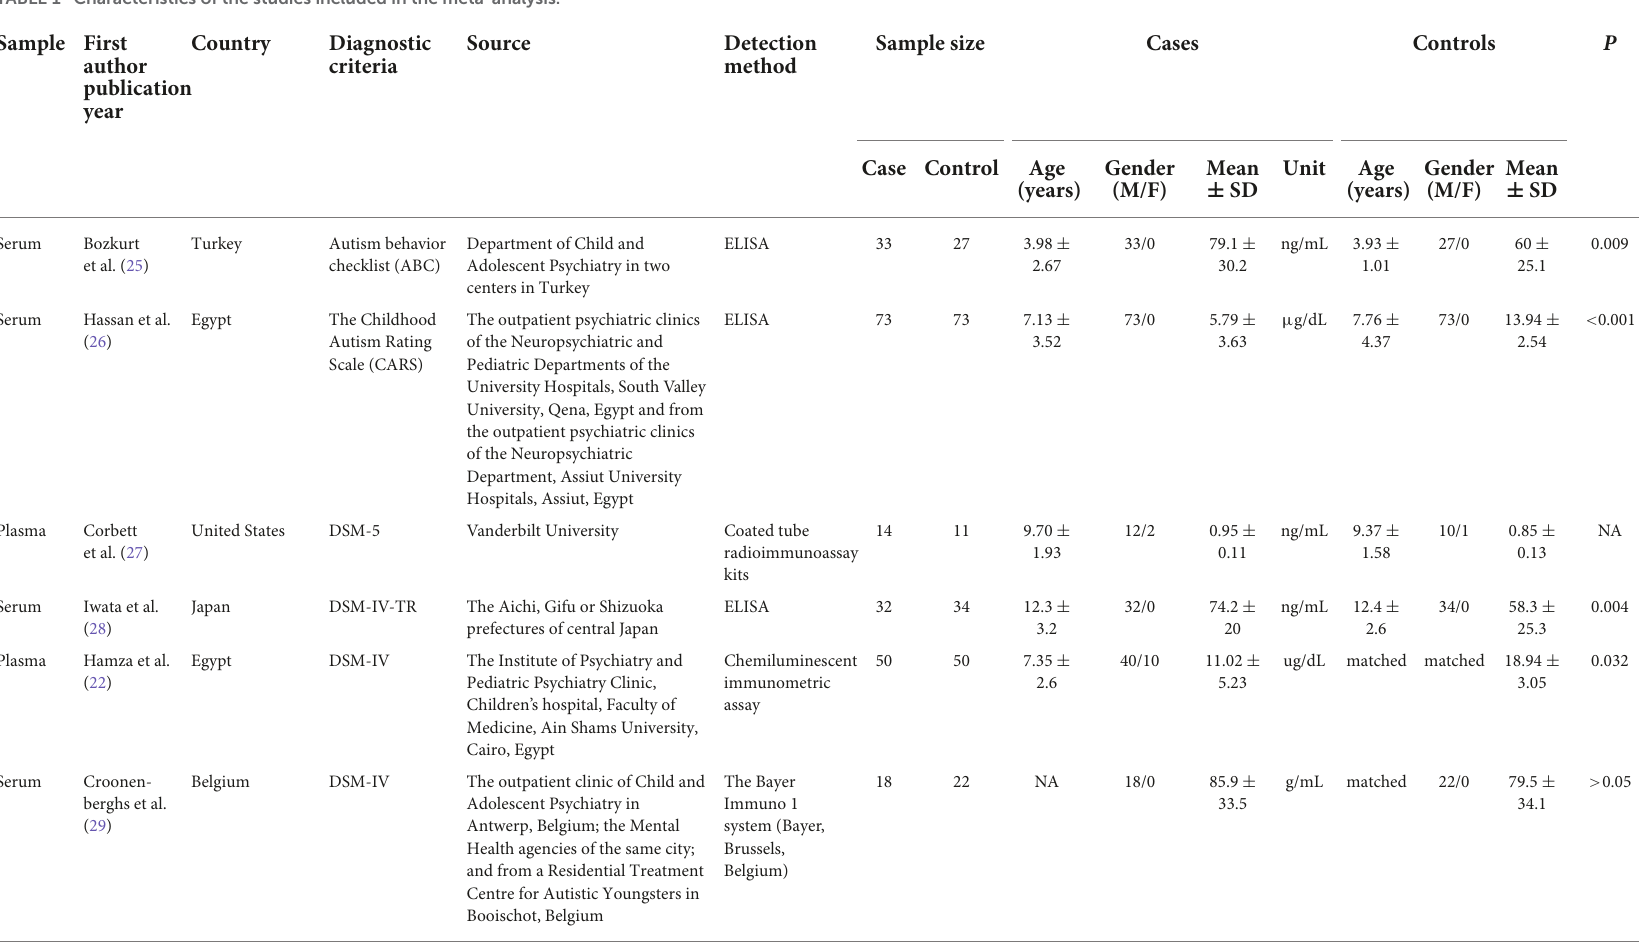
TABLE 1 Characteristics of the studies included in the